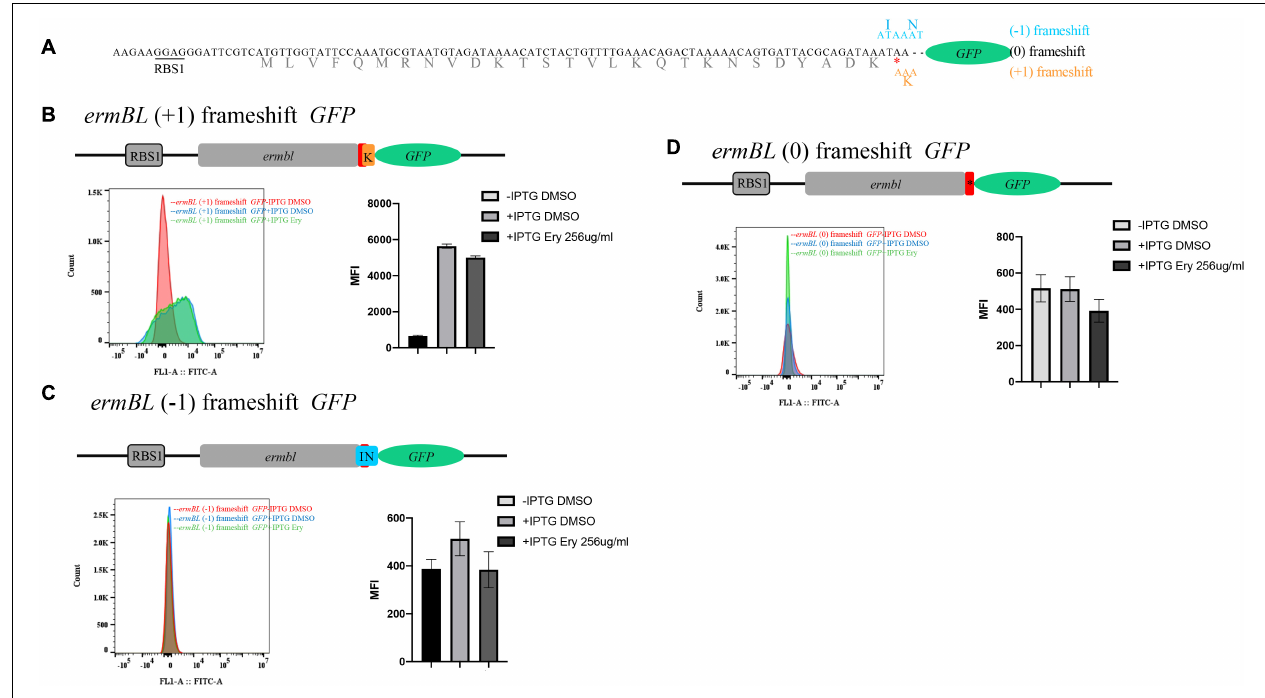
FIGURE 4 | ermBL GFP frameshift mutation reveals new leader peptide. (A) The structure of the ermBL reporter for testing erythromycin-dependent frameshifting. (B) Structure of the ermBL (+1) frameshift reporter, ermBL with TAA codon following two nucleotides (AT) fused to GFP . GFP does not have its own start codon. Flow cytometry of GFP intensity is shown. (C) Structure of the ermBL (0) frameshift reporter, ermBL with a TAA codon directly fused to GFP . GFP does not have its own start codon. Flow cytometry of GFP intensity is shown. (D) The structure of the ermBL ( − 1) frameshift reporter, ermBL with TAA codon following one nucleotide (A) fused to GFP . GFP does not have its own start codon. Flow cytometry of GFP intensity is shown. Data are mean ± SEM from three independent experiments (unpaired two-tailed Student’s t -test).